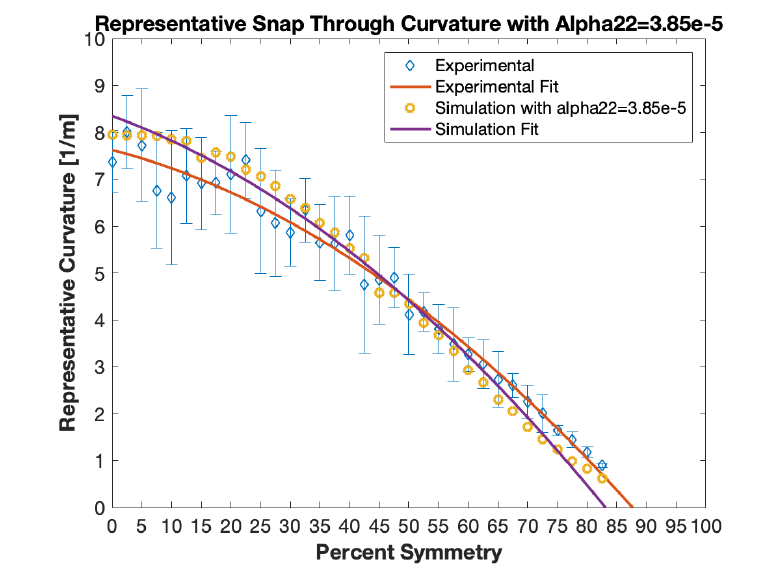
Figure 16. The snap through curvature versus the percent symmetry for all of the laminates simulated and studied that were bistable, using an α 22 value of 3.85 × 10 − 5 . Error bars on the experimental points show ± one standard